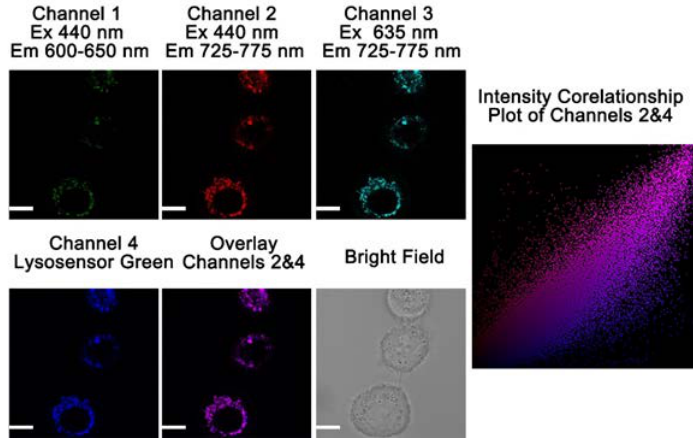
Figure 11. Live-cell fluorescence images of HeLa cells incubated with probe B + for 2 h and then with Lysosensor Green for 1 h with scale bars at 20 µm. The excitation of Lysosensor green is 405 nm and the fluorescence collect window is from 500 to 550 nm.